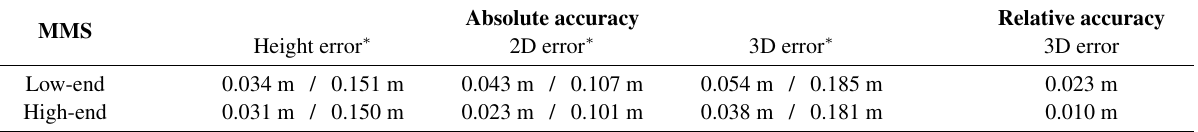
Table 4. Predicted absolute and relative accuracy of the low-end and high-end